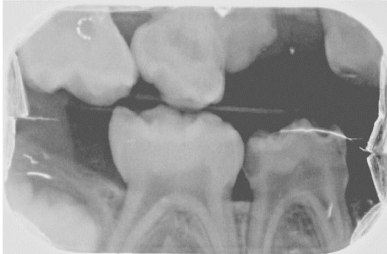
Figure 2: The right bitewing radiograph shows a suspicious area mesial to the maxillary right first primary molar. Caries are noted on the distal surface of the mandibular right first primary molar.